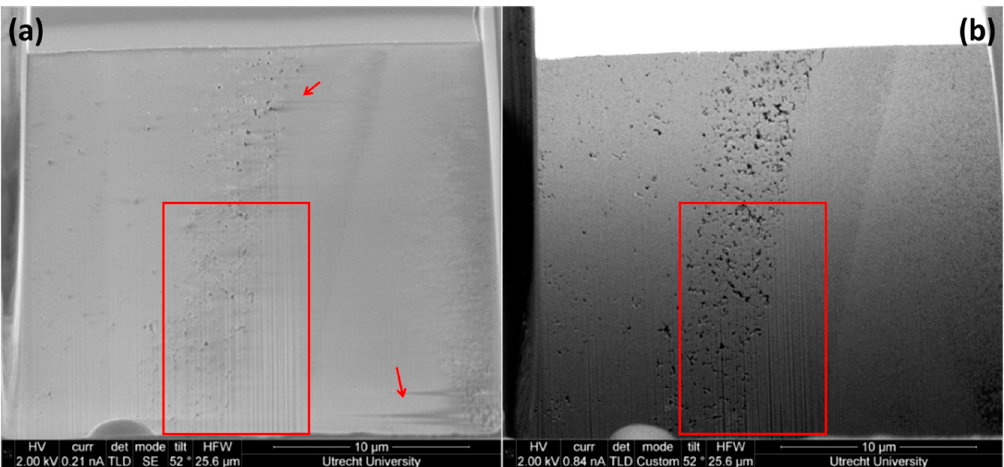
Figure 5. ( a ) SE imaging and ( b ) BSE imaging at 2 kV of the same section in the reacted olivine sample. In the rectangle is a region with curtaining effects; arrows indicate charging effect.